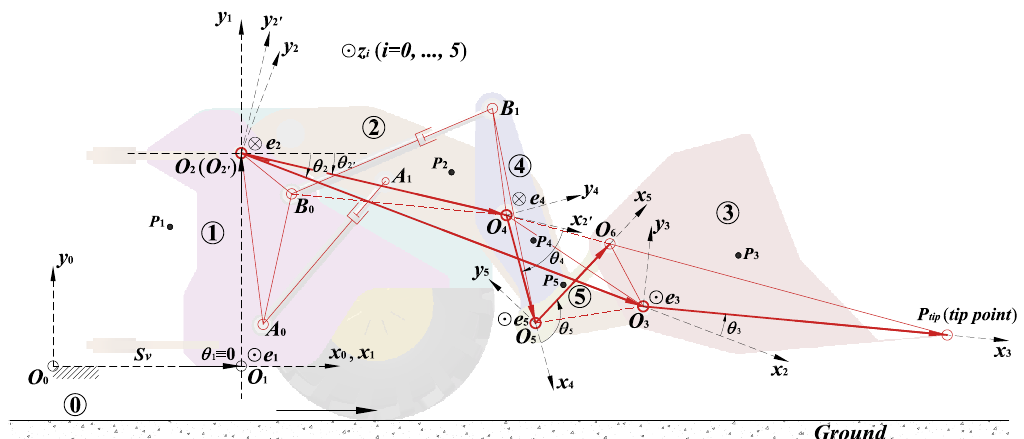
Figure 2. Kinematic model of the working mechanism